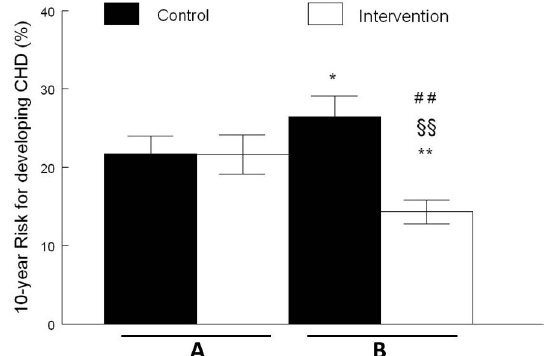
FIGURE 1 - Reduction of cardiovascular risk evaluated through the Framingham score. A: basal values before the interventions; B: values calculated after six month of control or intervention follow-up. Values are expressed as the mean ± S.E.M. * p<0.05 and ** p<0.01 compared with initial Control values; ## p<0.01 compared with initial Intervention values; §§ p<0.01 compared with final Control values.